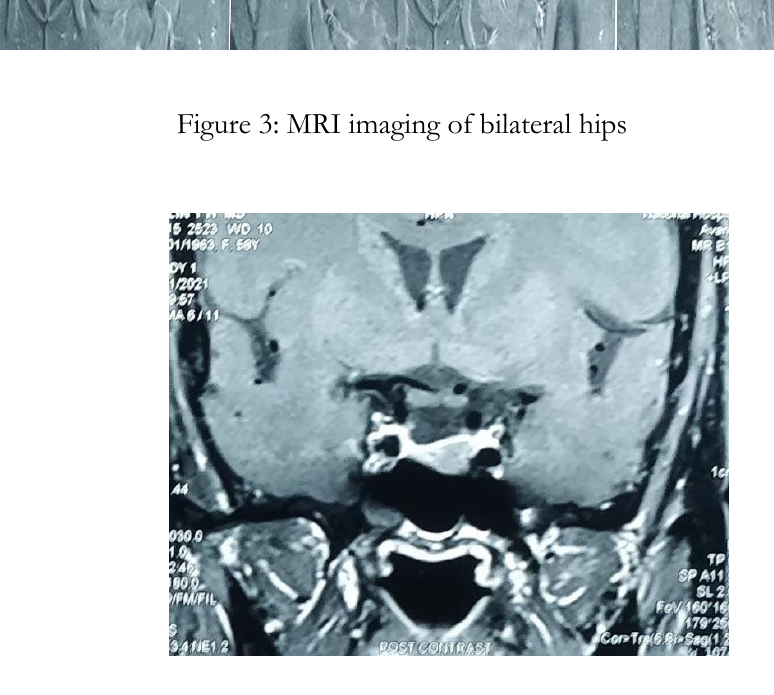
Figure 4: MRI pituitary post contrast imaging showing 10x 7x 8mm lesion on the left side of the